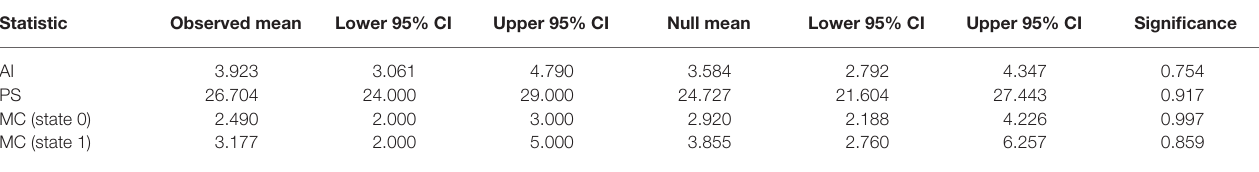
TABLE 1 | The results from the four test statistics used by bayesian tip-association significance testing (BaTS) to determine if there were phylogenetic-trait associations between SLEV and its mosquito vectors Culex quinquefasciatus and Cx. tarsalis .